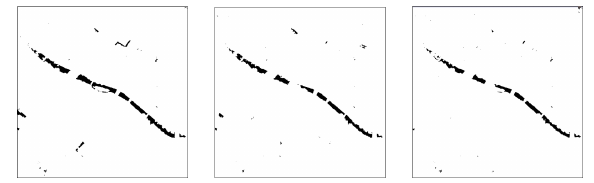
Figure 7. Mask T derivation based on OSM data affected DTM computation using L 1 spline (left) and L 2 spline (middle) interpolation and Gridfit method (right).